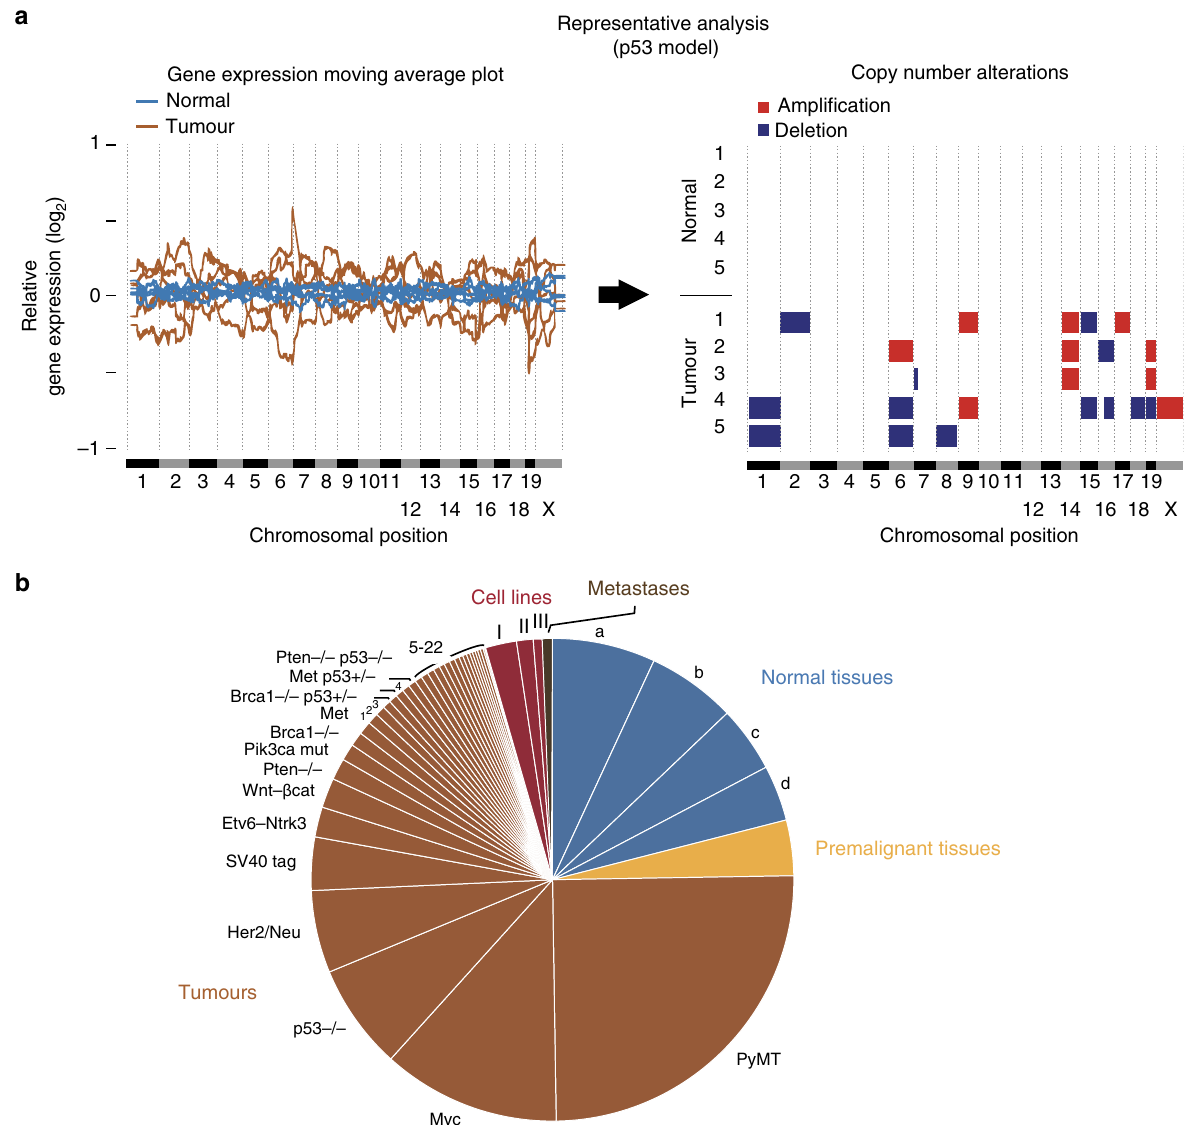
Figure 1 | Analysing aneuploidy and large CNAs in breast cancer GEMMs using gene expression profiles. ( a ) A representative example of gene expression-based CNA analysis. Left: moving average plots of global gene expression levels along the genome of five normal mammary samples (blue lines) and five tumour samples (brown lines) from the p53 (cid:2) / (cid:2) model. Right panel: piecewise constant fit (PCF) detection of CNAs in the same samples based on coordinated deviations of gene expression levels throughout large genomic regions. Amplifications are shown in red, deletions in blue. ( b ) A pie chart describing the 2,697 gene expression profiles analysed: 567 normal tissue samples, 100 premalignant mammary tissues/lesions, 1,910 primary mammary tumours, 17 breast cancer metastases, and 103 breast cancer cell lines and cell line-derived tumours. These data were collected from 36 unique breast cancer mouse models. Letters represent normal tissues: a, non-mammary tissues from transgenic mice; b, mammary tissues from female control mice; c, non-mammary tissues from control mice; and d, mammary tissues from female transgenic mice. Roman letters represent cell lines and tumours derived from them: I, established breast cancer cell lines; II, cell line-derived tumours; and III, freshly derived cell lines. Tumours from GEMMs with 4 20 samples are presented by name, and numbers represent tumours from the remaining GEMMs: 1, Igf1r; 2, Apc þ / (cid:2) ; 3, Pten (cid:2) / (cid:2) p53 (cid:2) / (cid:2) ; 4, Hras; 5, Brg þ / (cid:2) ; 6, Brca2 (cid:2) / (cid:2) ; 7, Stat5 (cid:2) / (cid:2) ; 8, Wnt Fgfi; 9, DMBA; 10, p53 þ / (cid:2) IR; 11, Rb (cid:2) / (cid:2) ; 12, Int3/Notch4; 13, Brca1 þ / (cid:2) p53 þ / (cid:2) IR; 14, p18 (cid:2) / (cid:2) ; 15, LPA1; 16, Pten (cid:2) / (cid:2) Her2/Neu; 17, Stat1 (cid:2) / (cid:2) ; 18, Atx; 19, Lpa2; 20, Lpa3; 21, Twist1 Kras; and 22, Pik3ca-mut p53 (cid:2) / (cid:2) . See also Supplementary Fig.